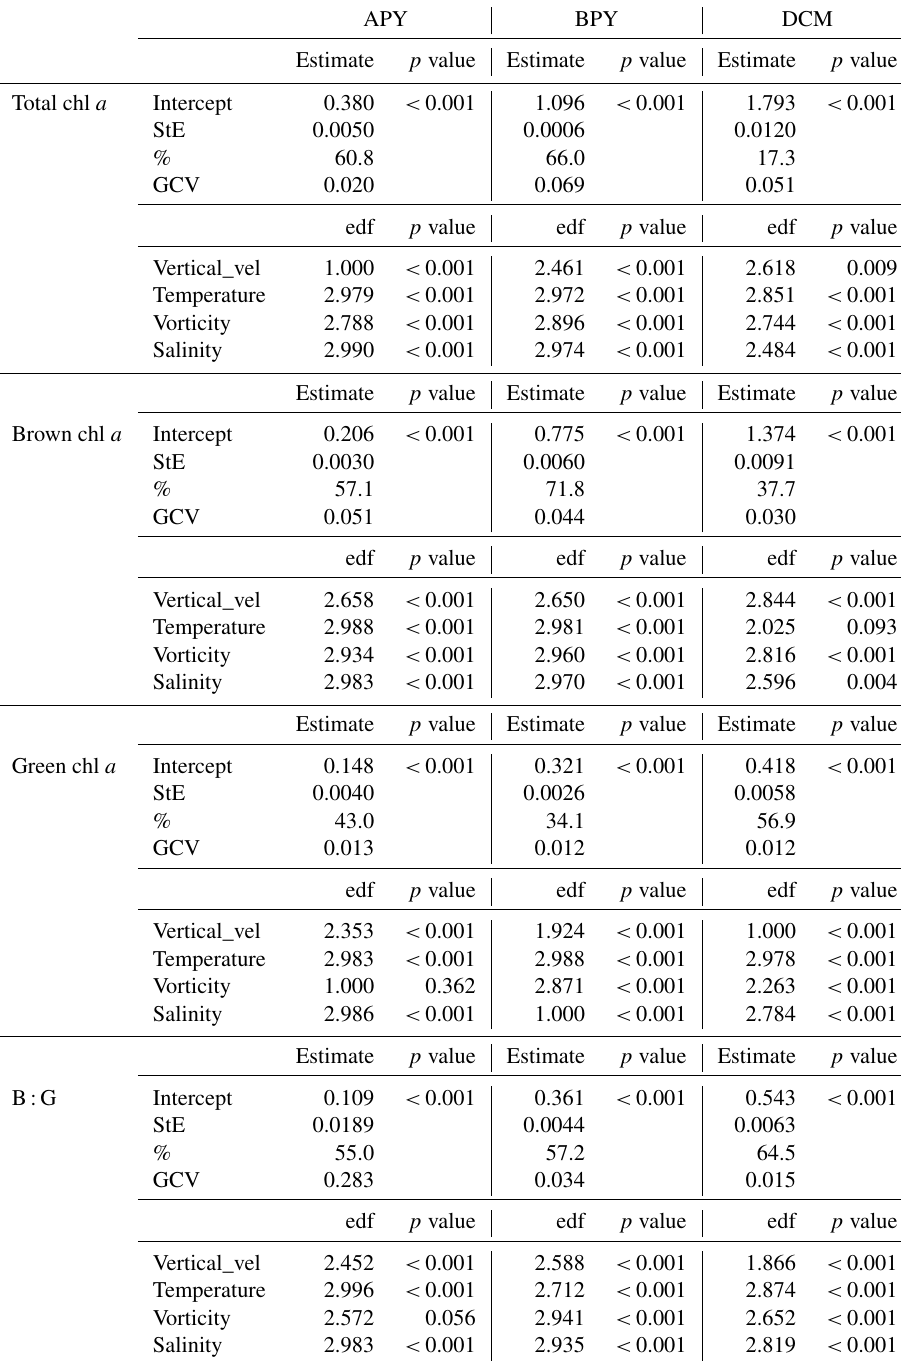
Table 1. Generalized additive model (GAM) results. Intercept, standard error (StE), significance ( p value), and explained variance (%) of the GAMs for the water column sections “Above the pycnocline” (APY), “below the pycnocline” (BPY) and at the deep chlorophyll maximum (DCM). Dependent variables are the estimated chl a concentrations for the different algae groups, and B : G refers to the brown chl a to green chl a ratio. The estimated degrees of freedom (edf) and significance ( p value) of the environmental variables are also included. Although salinity and temperature were correlated for the section BPY, both variables were kept since the fit ( R 2 and general cross-validation, GCV) was better in all